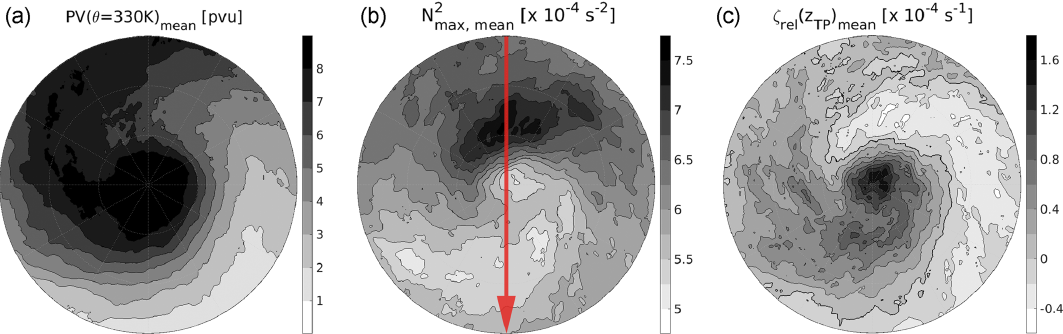
Figure 7. Composite of flow features for the 76 strong cyclones with p msl , min ≤ 990hPa at the point in time of maximum intensity: (a) IPV on 330K, (b) TIL strength N 2 max , and (c) relative vorticity ζ rel at lapse rate tropopause height. The ζ rel = 0s − 1 isoline is indicated by the black solid line. The red arrow in the middle indicates the orientation of the cross section in Fig.